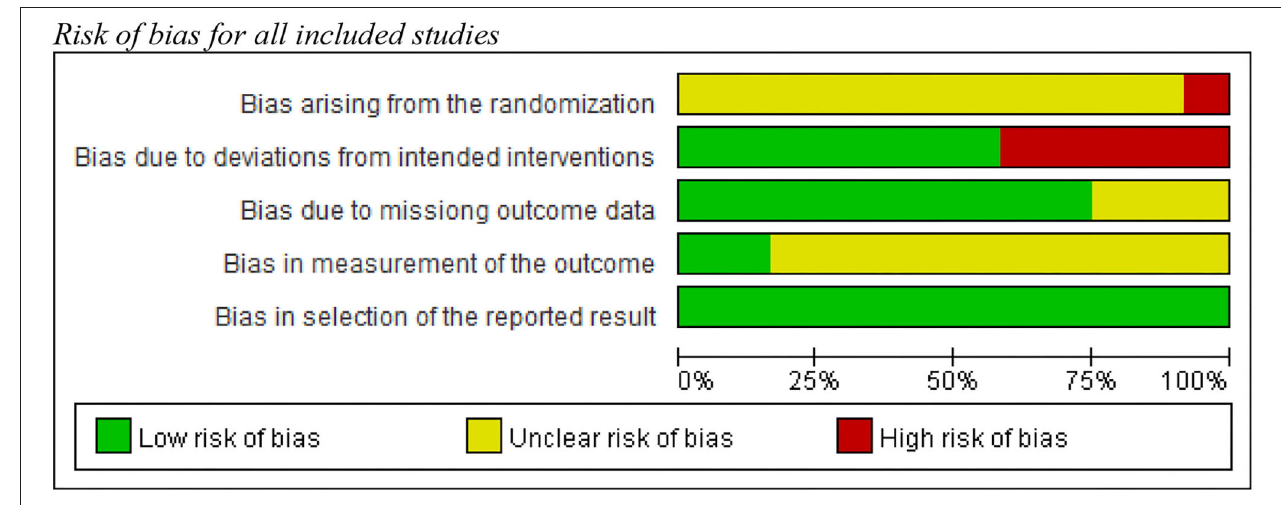
FIGURE 2 | Risk of bias for all included